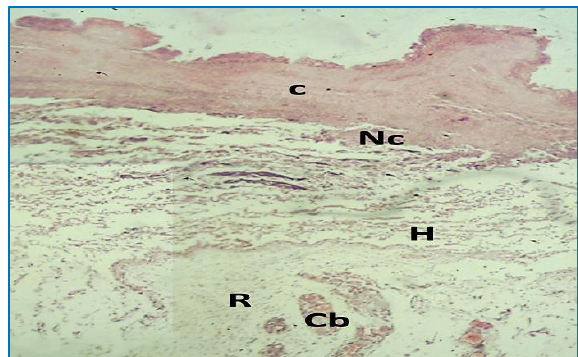
Figure, 5: Section of skin (7 days post treatment with amniotic membrane). Fibrin clot (C), necrotized cells (Nc), hemorrhage (H), regeneration (R), and blood vessels (Cb). Hand E, 40x.